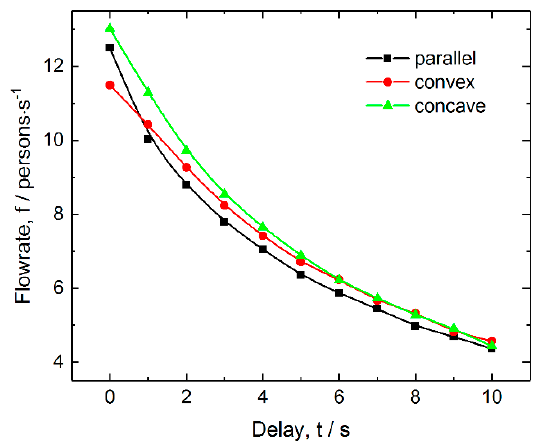
Figure 5. Total flowrate as a function of delay for the three layouts of inspection points. The density of pedestrian and failure probability are 3.5 persons/m 2 and 0.08, respectively.